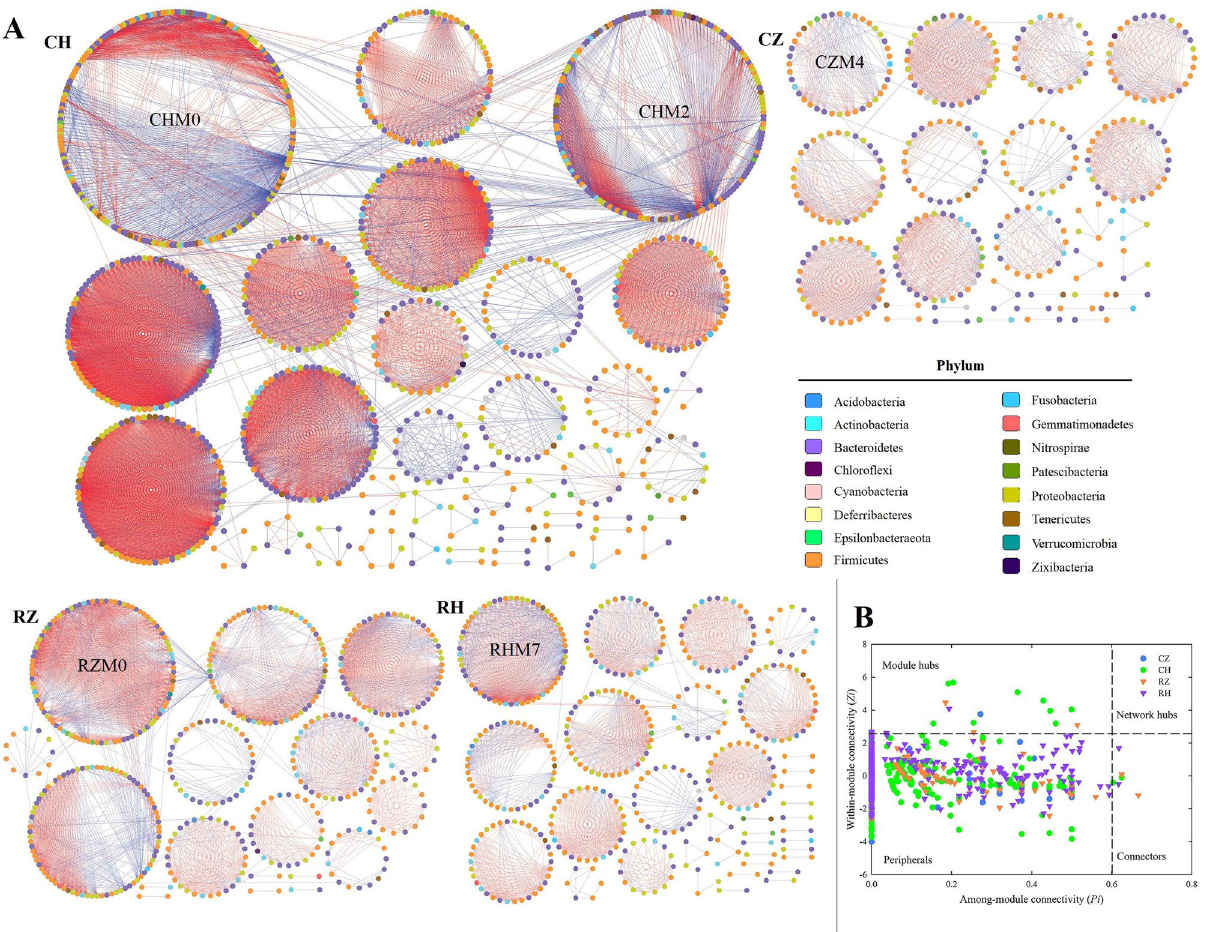
Figure 6. Ecological networks of intestinal microbiota in the six groups ( A ). Ecological network graph with submodule structure was obtained using the fast-greedy modularity optimization method. Each node indicates one OTU at the phylum level. Node colors indicate different major phyla. Blue edges indicate a positive interaction between two individual nodes, while red edges indicate a negative interaction. Z-P plot showing the distribution of operational taxonomic units (OTUs) based on their topological roles ( B ). Species with both a low Zi (value < 2.5) and a low Pi (value < 0.6) were peripheral species, i.e., they had only a few links, and these were almost always only to species within their module. Species with either a high value of Zi (≥ 2.5) or Pi (≥ 0.6) were module hubs, connectors and network hubs, as they were highly connected species linked to many other species within their own